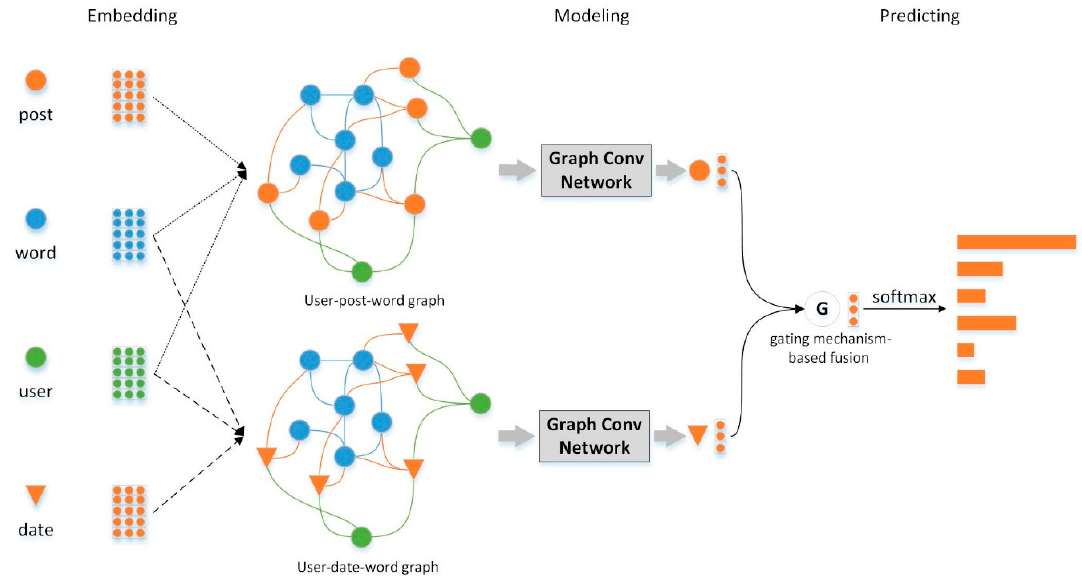
Figure 2. Time Gated Human Activity Graph Convolutional Network (TG-HAGCN) model.